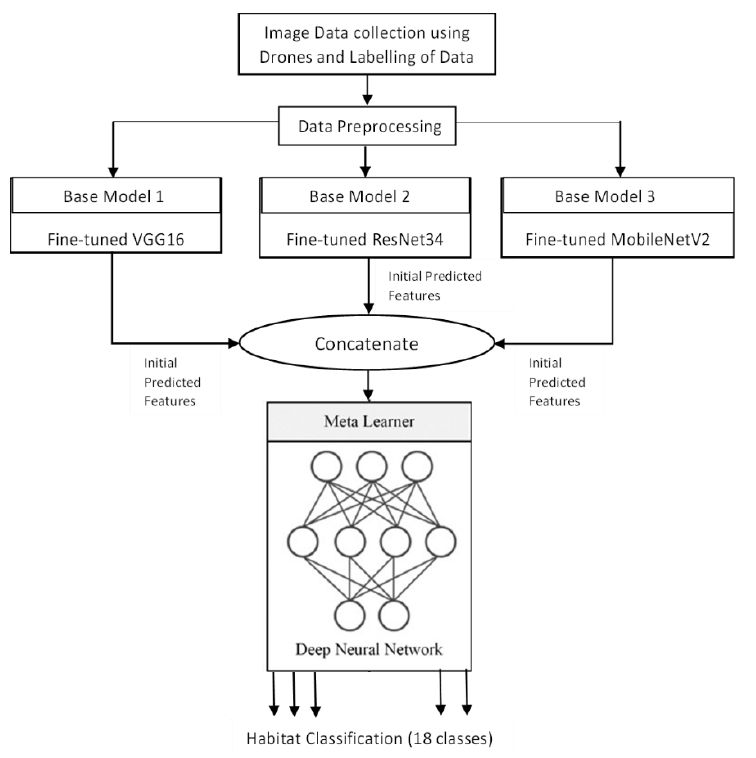
Figure 1. Workflow of the System.